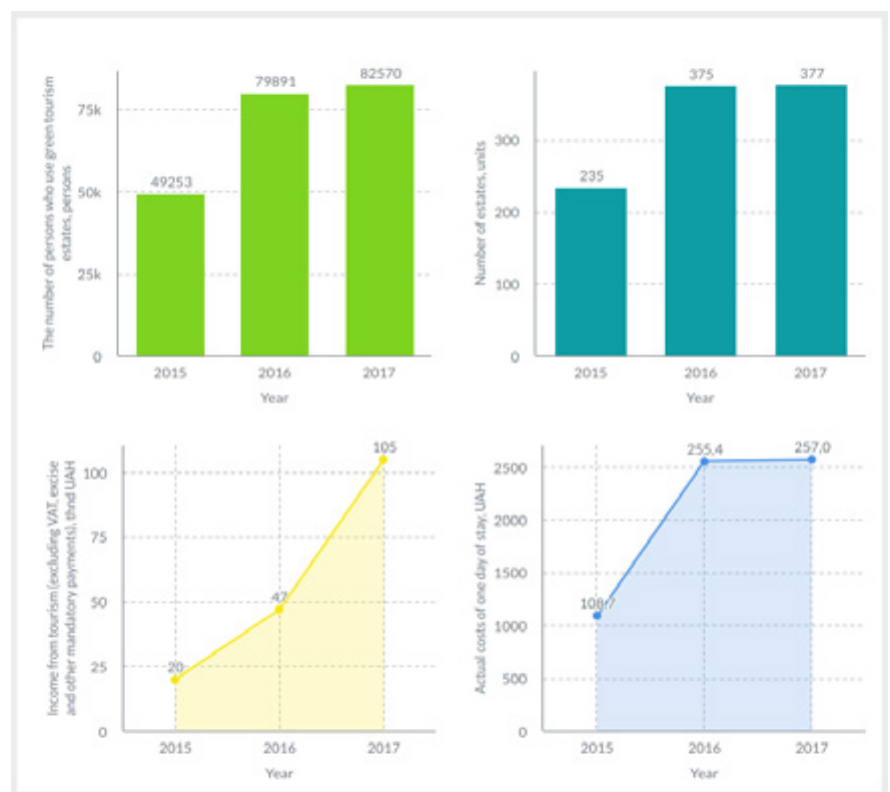
Fig. 1: The indicators of the green tourism development level of Ukraine in 2015-2017 (SSSU, 2020)